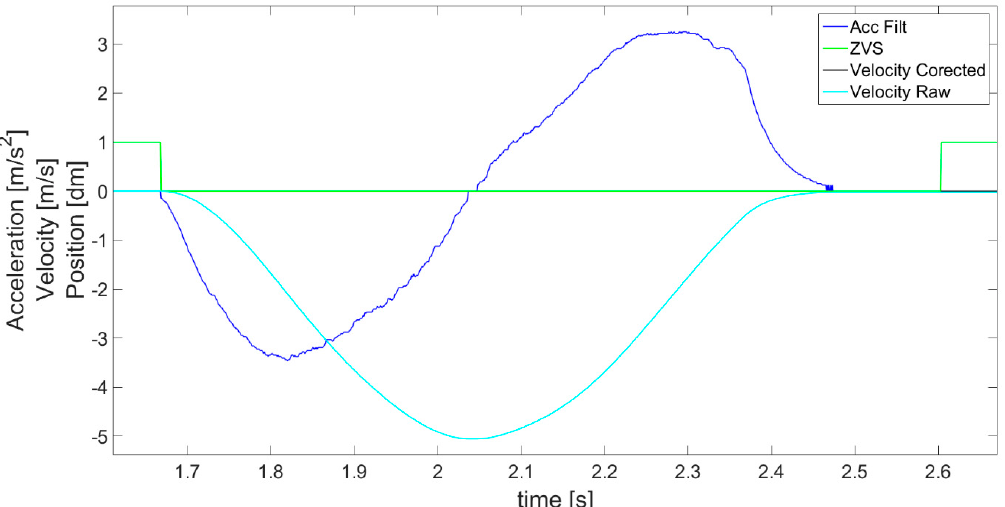
Figure 8. Magnification of part of Figure 7 presenting the effect of the first velocity correction based on coefficient subtract in the detected ZVS periods.